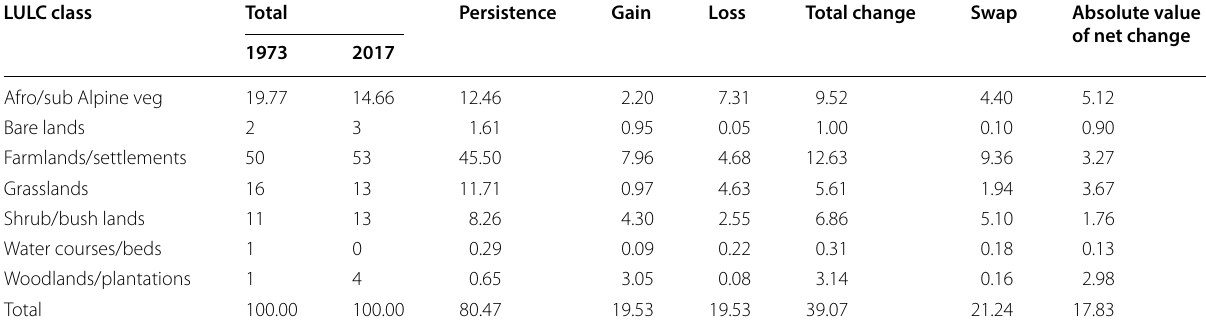
Table 7 Summary of % of LULC gain, loss, swap and absolute net changes in Gedalas watershed (1973–2017) LULC class Total